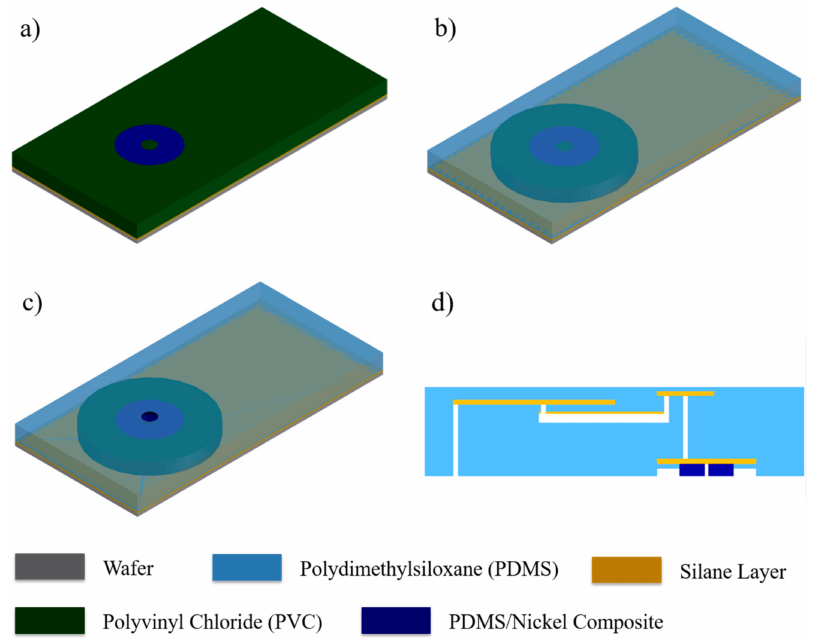
Figure 4. Magnetically actuated micro-valve fabrication. ( a ) Paste PVC stencil on silanized wafer. Remove circular band and fill with nickel-PDMS composite. ( b ) Remove rectangular stencil and spin coated PDMS over the wafer. ( c ) remove center circle PVC stencil leaving a hole in the center. ( d ) Cross-sectional view of the drug delivery device after integration with chamber layer, valve layer and slab of